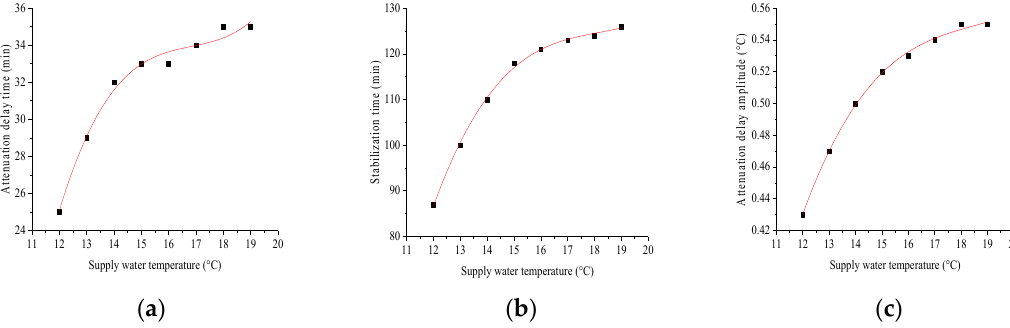
Figure 10. Change of attenuation delay time ( a ), stabilization time ( b ) and attenuation delay amplitude ( c ) of indoor air with different supply water temperature of CRC system.